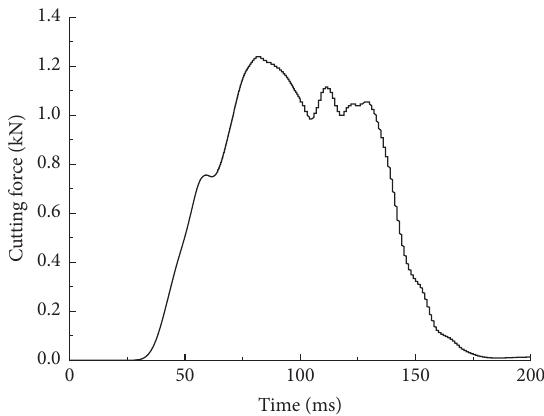
Figure 12: Variation of cutting force with time.